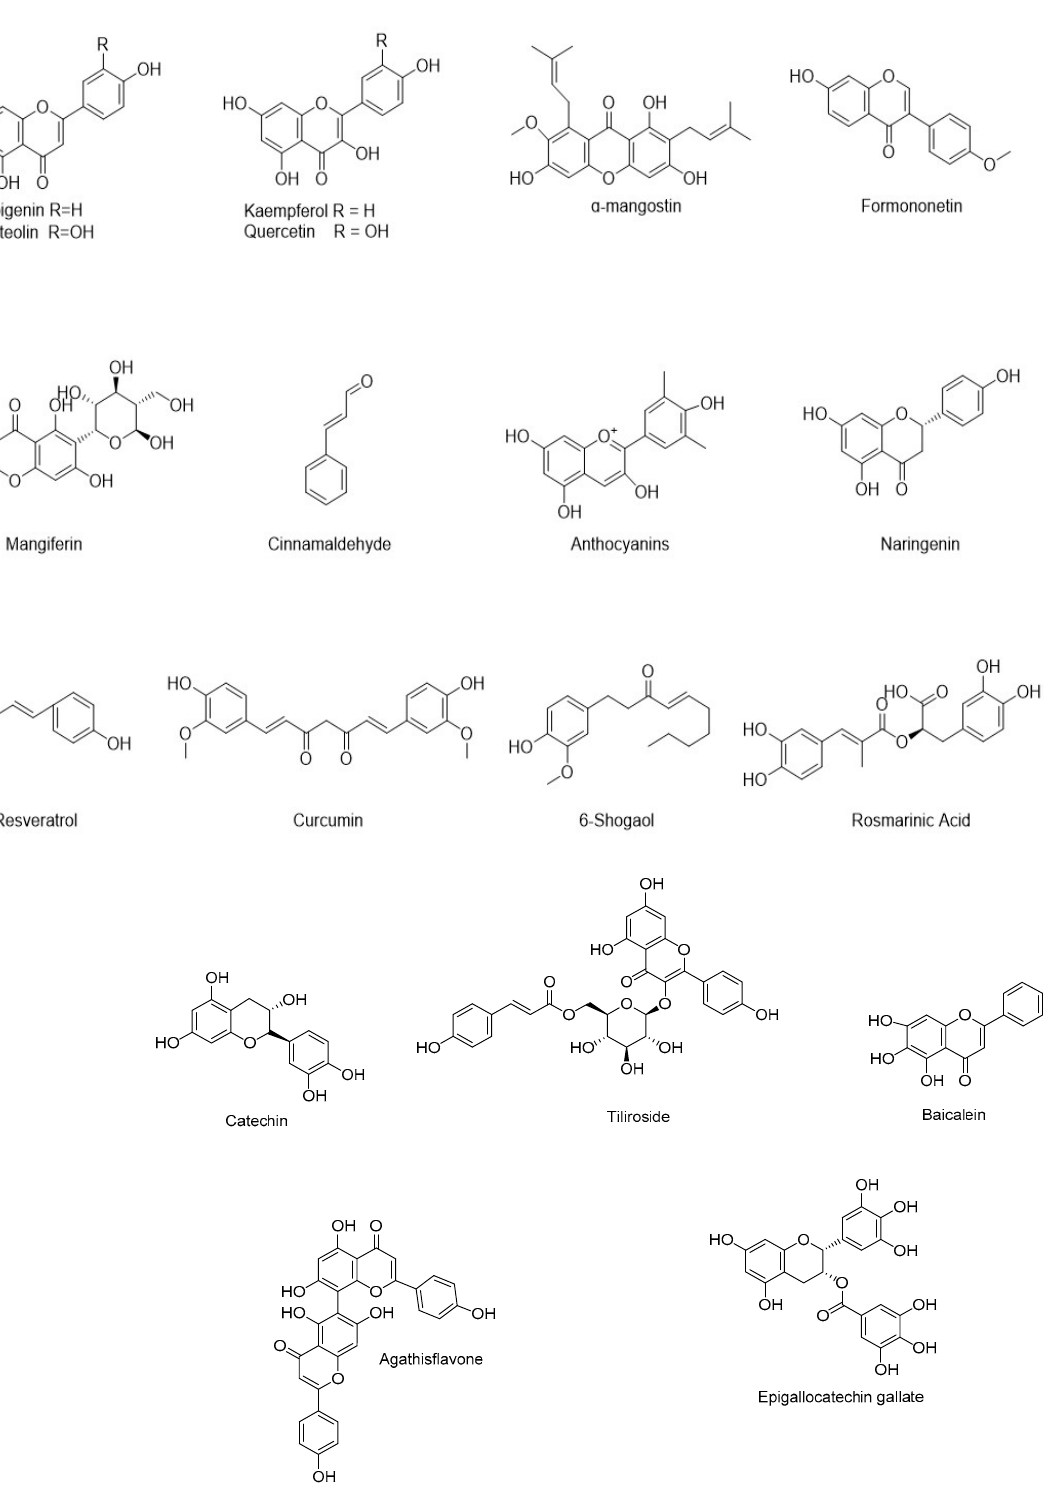
Figure 5. Chemical structure of natural flavonoids and other polyphenol with anti-inflammatory activity.